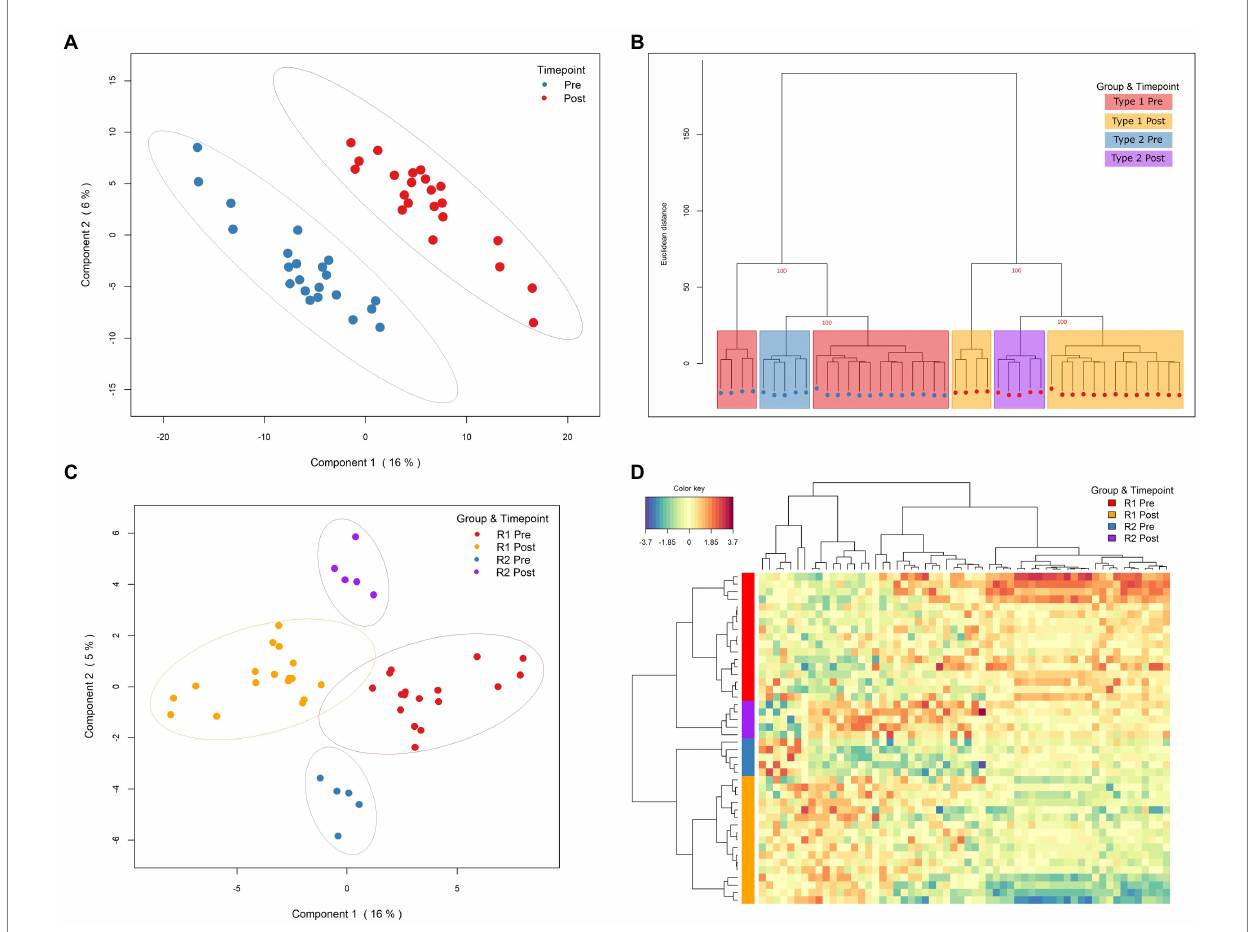
FIGURE 1 Main steps of the metabolomic-based clustering procedure. Panel (A) shows participants spanned by the two main components derived from partial least squares discriminant analysis (PLS-DA) grouped by timepoint (pre- and post-intervention, respectively in blue and red). Each ellipse represents the 95% confidence interval for each timepoint group. Panel (B) shows the four clusters of participants identified from hierarchical clustering analysis (HCA). Red and orange squares regroup type 1 responders at pre- and post-intervention timepoints. Blue and purple squares represent type 2 responders at pre-and post-intervention timepoints. Numbers in red represent the approximately unbiased p -values of each cluster. Panel (C) shows participants spanned by the two main components derived from sparse PLS-DA portraying the two distinct response subgroups identified from HCA. R1 pre-and R1 post-intervention subgroups are colored in red and orange, respectively. R2 pre- and R2 post-intervention subgroups are colored in blue and purple, respectively. (D) Heatmap illustrating the classification of participants based on the most discriminating metabolites derived from sparse partial least squares discriminant analysis (sPLSDA). The left dendrogram branches in four major nodes, representing the clustering of participants. The upper dendrogram branches in two major nodes, representing the first component with its 30 metabolites on the right, and the second component with its 30 metabolites on the left. The intensity of red color indicates an increase in metabolite levels between pre-and post- intervention